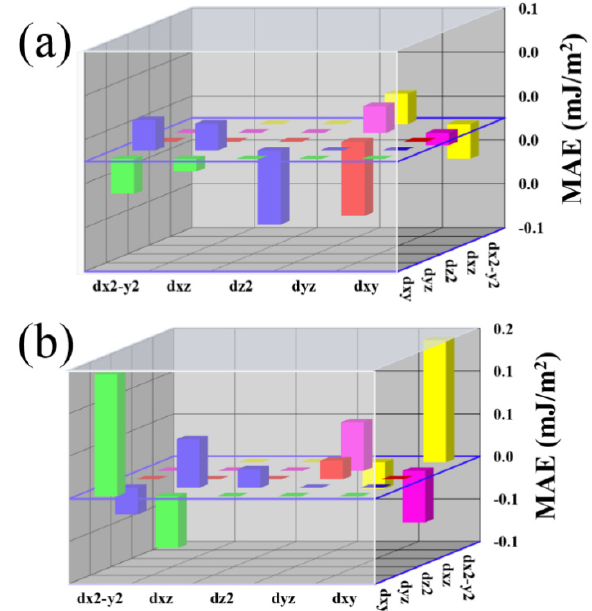
Figure 7. The d -orbital-resolved MAE of Fe atom in − 6% ( a ), and + 6% ( b ) strains in C-1 stacking configuration.